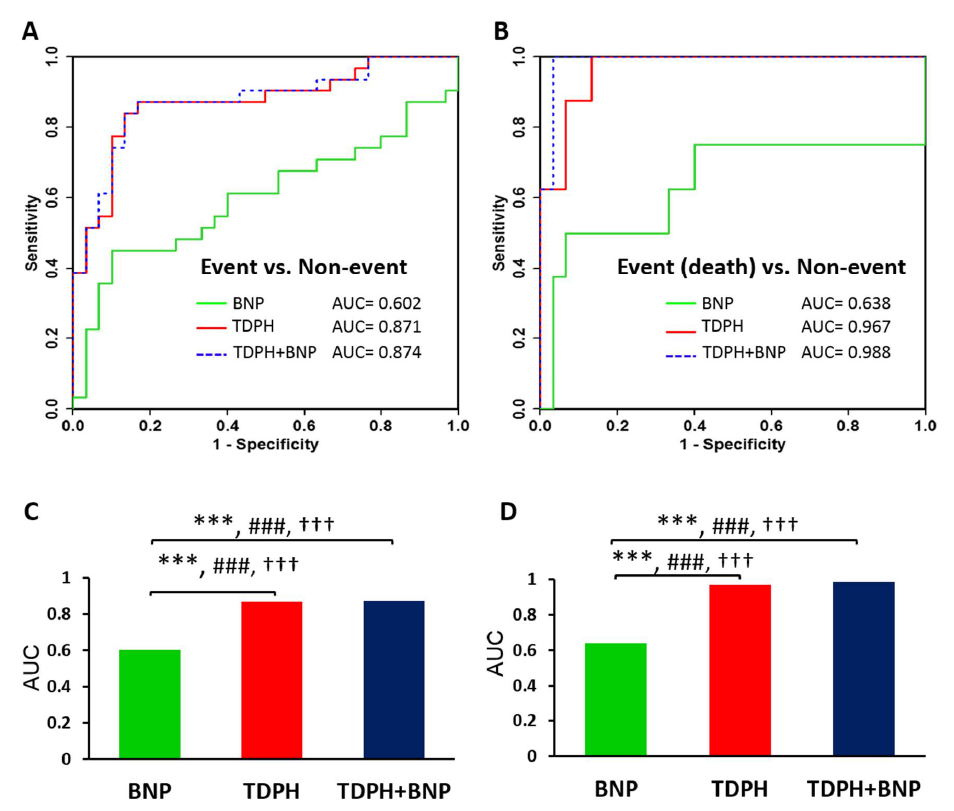
Figure 3. ROC AUC analysis plots. Comparison between the AUC with ( A ) ROC curves for the discrimination of the event patients and non-event patients using BNP, four metabolites (tetradecenoylcarnitine + dimethylxanthine + phenylacetylglutamine + hypoxanthine (TDPH)). ( B ) ROC curves for the discrimination of the event patients (death) and non-event patients using BNP, four metabolites (tetradecenoylcarnitine + dimethylxanthine + phenylacetylglutamine + hypoxanthine (TDPH)). The AUC values for respective ROCs in event versus non-event ( A , C ) and event (death) versus non-event ( B , D ) models are shown. Statistically significant differences between two AUCs with DeLong’s test are indicated *** p < 0.001. Significant increases in ability of prediction as assessed by integrated discrimination improvement (IDI) and the net reclassification improvement (NDI) are indicated # and †, respectively. ### or ††† p < 0.001.